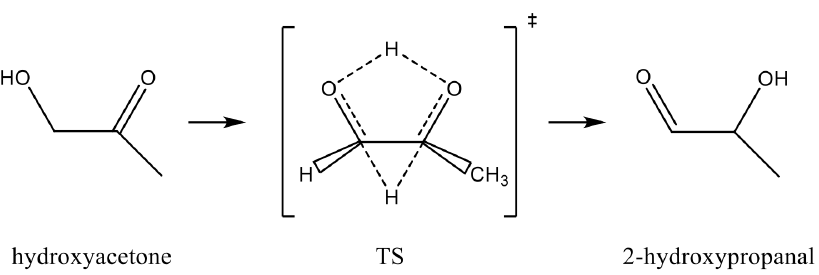
Figure 3. Direct isomerization reaction mechanism between hydroxyacetone and